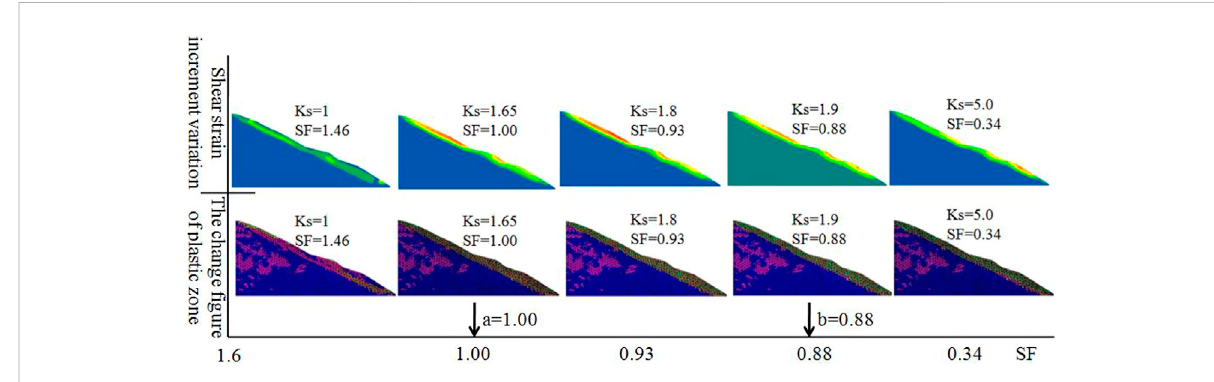
FIGURE 11 Shear strain increment variation and changes in the plastic